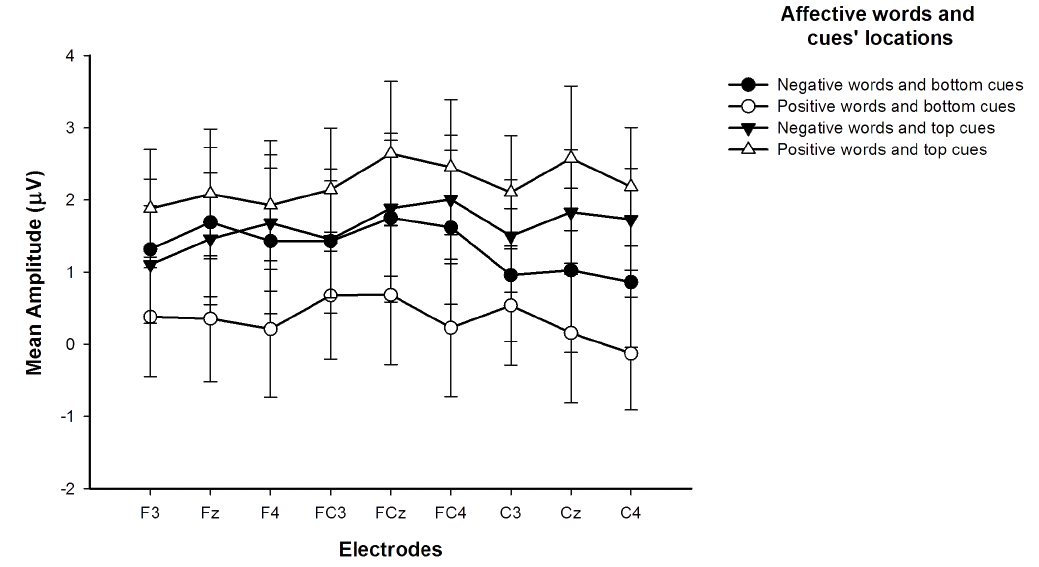
Figure 5. Mean amplitude for four different trial types at nine electrode sites.